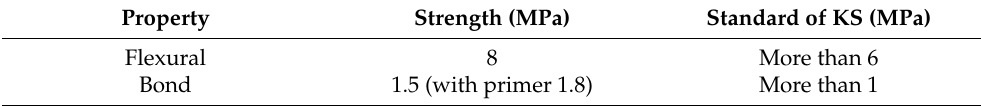
Table 3. Flexural and bond strength of polymer